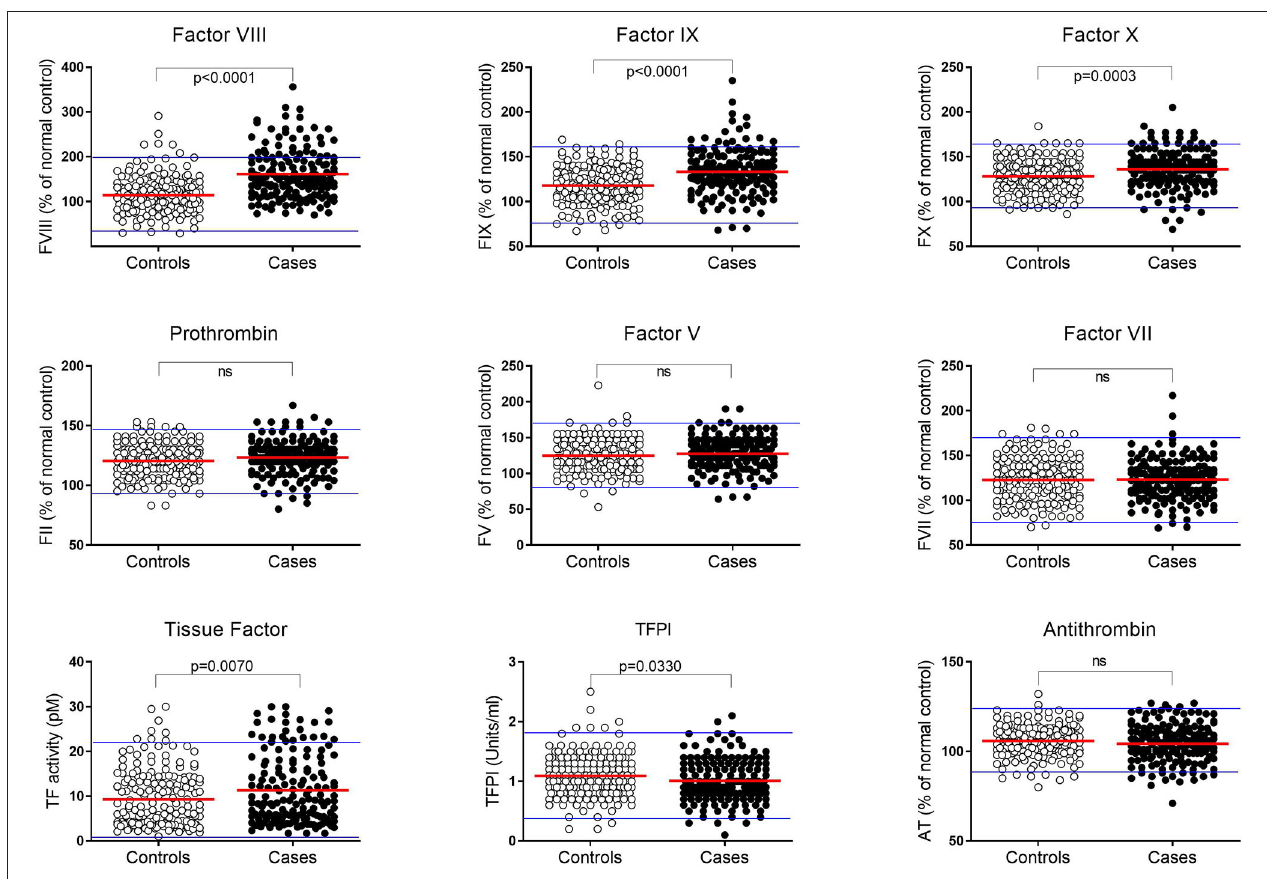
FIGURE 2 | Plasma coagulation factor levels in premature MI subjects and controls . Levels of each coagulation factor were measured in plasma from pMI cases ( n = 162; closed circles) and controls ( n = 186; open circles). Factors II, V, VII, VIII, IX, X, and antithrombin (AT) are reported as the percentage of reference control plasma included in each analysis. Tissue Factor (TF) and Tissue Factor Pathway Inhibitor (TFPI) are reported as activity (pM) and (U/mL), respectively. A normal range for each protein is depicted by the upper and lower blue lines and is based on the mean value ± 2SDs in plasma from the healthy controls. ( P -values derived by unpaired t-test after confirming data were normally